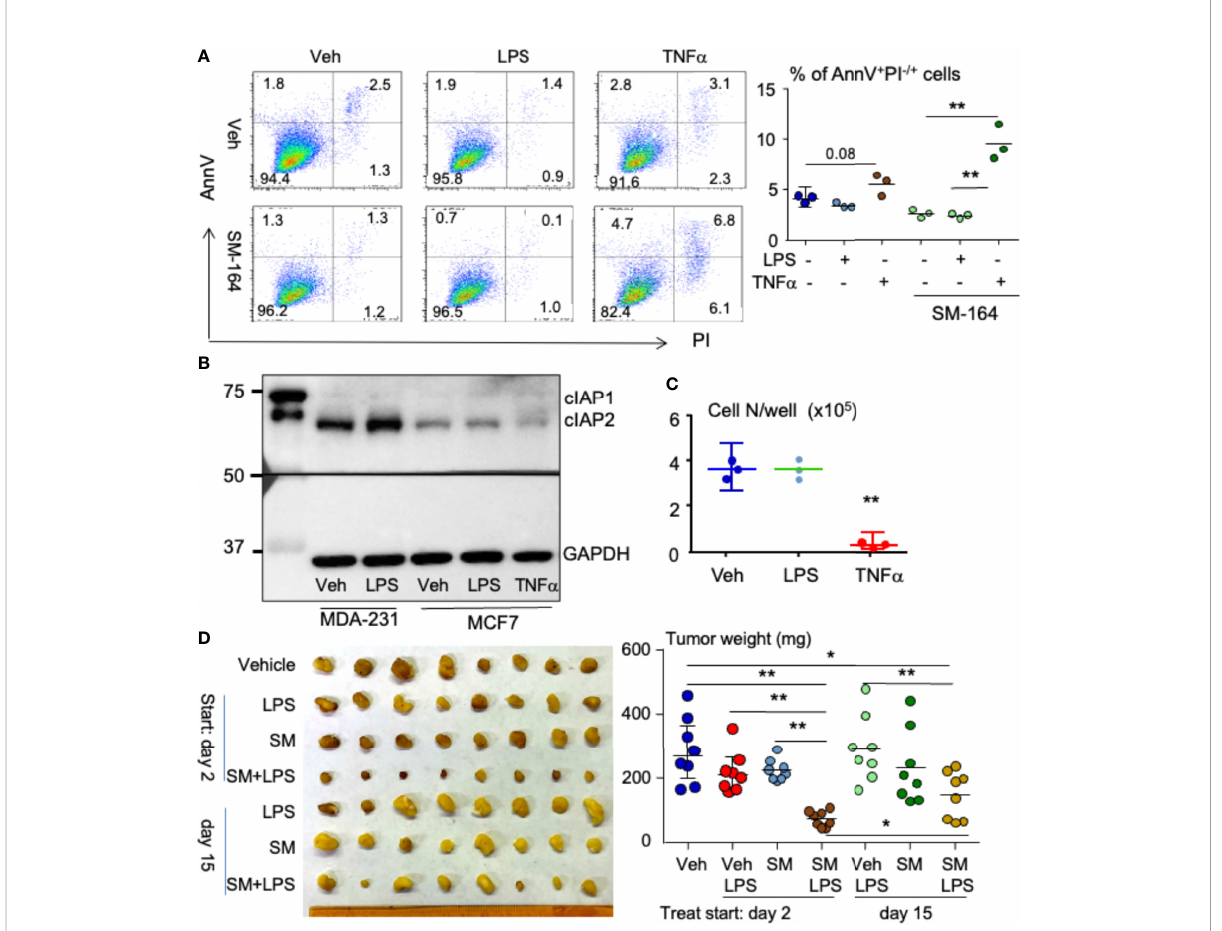
FIGURE 7 LPS in combination with an IAP antagonist induces ER + breast cancer regression in mouse model. (A) 2 × 10 5 MCF7 cells were cultured in 60- mm dishes for 24 h followed by treatment overnight with vehicle, 100 ng/ml of LPS, or 1 ng/ml of TNF a alone or each of them in combination with 3 nM of SM-164. AnnV + PI − /+ apoptotic cells were analyzed by fl ow cytometry. The data were from three repeat samples in one experiment. *p < 0.05 and **p < 0.01 between the indicated groups. (B) MDA-MB-231 or MCF7 cells at sub-con fl uent in 60-mm dishes were treated with vehicle, LPS, and/or TNF a for 8 h; 20 m g of cell lysate protein from each sample was used to test protein levels of cIAP1/2 by WB. (C) 4 × 10 4 MCF7 cells in a well of 6-well plates were treated with vehicle, LPS, or TNF a for 8 days. The cells in each well were digested with 0.25% of trypsin to count cell number. Three repeats for each treatment. **p < 0.01 vs . Veh or LPS. (D) 2 × 10 5 MCF7 cells were injected into the second left mammary fat pad of a female NSG mouse. On days 3 and 15 after cancer injection, the mice were treated with vehicle, 1 m g of LPS, 3 mg/kg of SM-164 (SM), or their combination for 4 weeks. The mice were euthanized, and the tumors were collected to scale their weight, eight in each group *p < 0.05, **p < 0.01. LPS, lipopolysaccharide; IAP, inhibitor of apoptosis protein; WB, Western